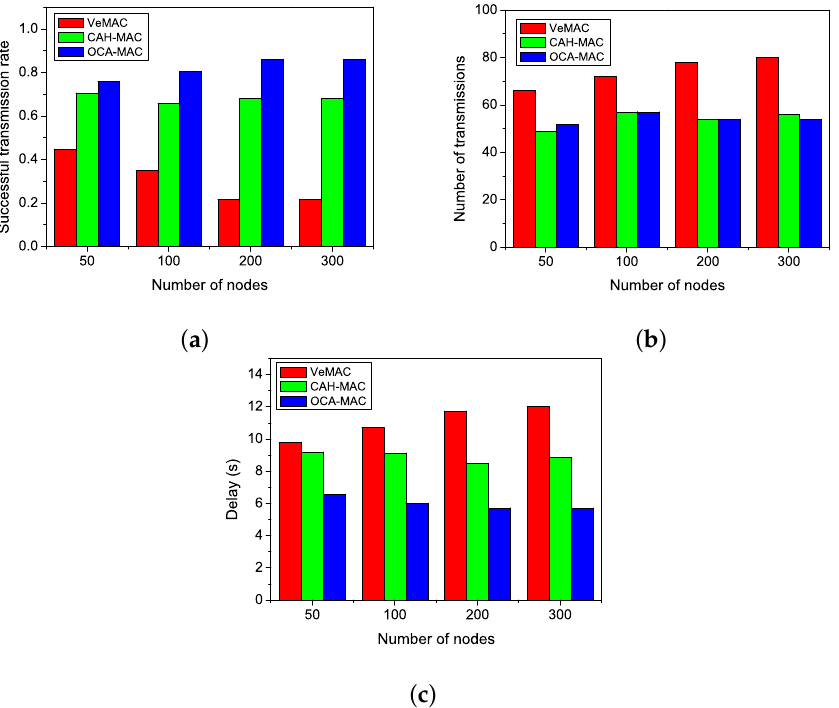
Figure 6. Influence of the number of nodes on the performance. ( a ) Successful transmission rate. ( b ) Number of transmissions. ( c )